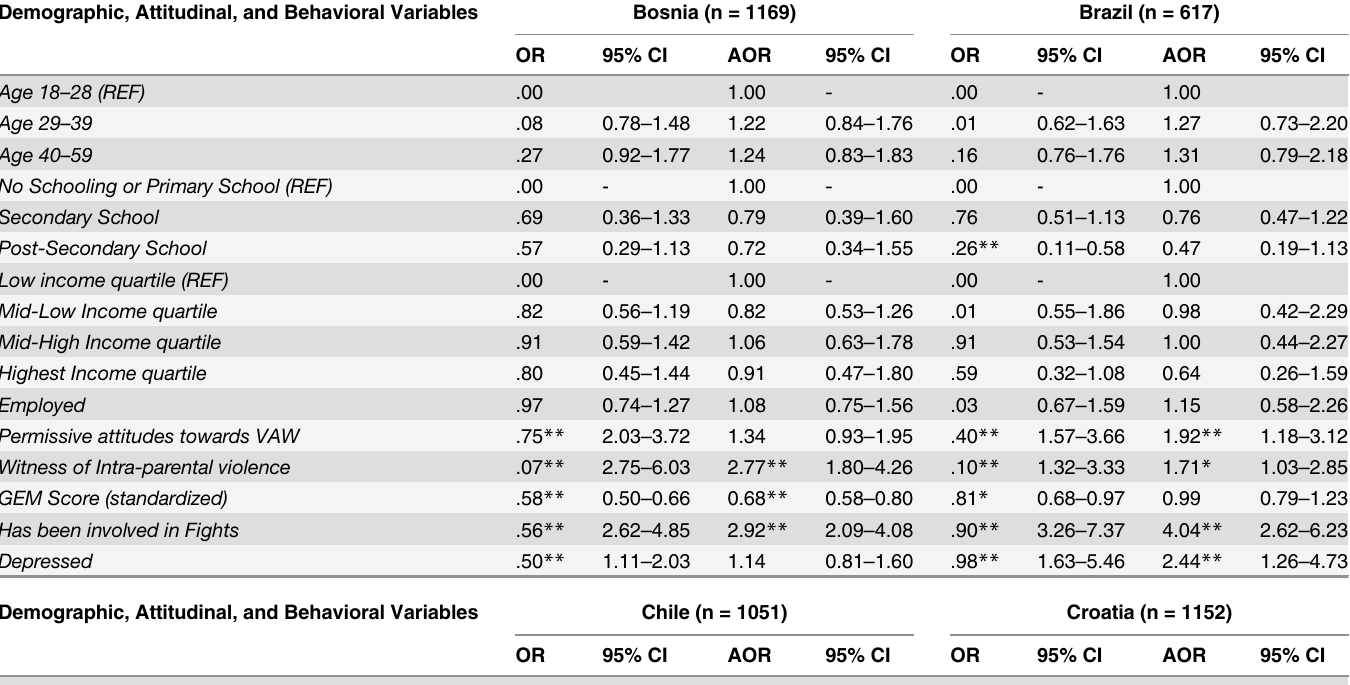
Table 4. Results from multivariate logistic regression, correlates of lifetime physical violence perpetration against a partner, presented as unadjusted odds ratios and adjusted odds ratios a . Demographic, Attitudinal, and Behavioral